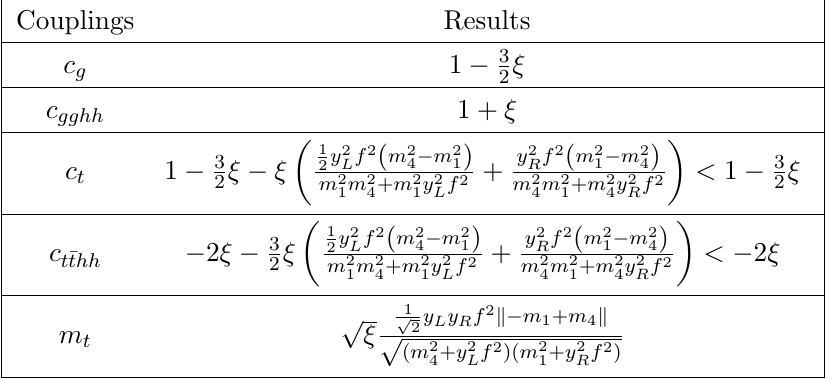
Table 3 . Higgs Couplings and top mass in MCHM of 5 + 5 Representation, which means t L and t R are both embedded in the 5 of SO(5).